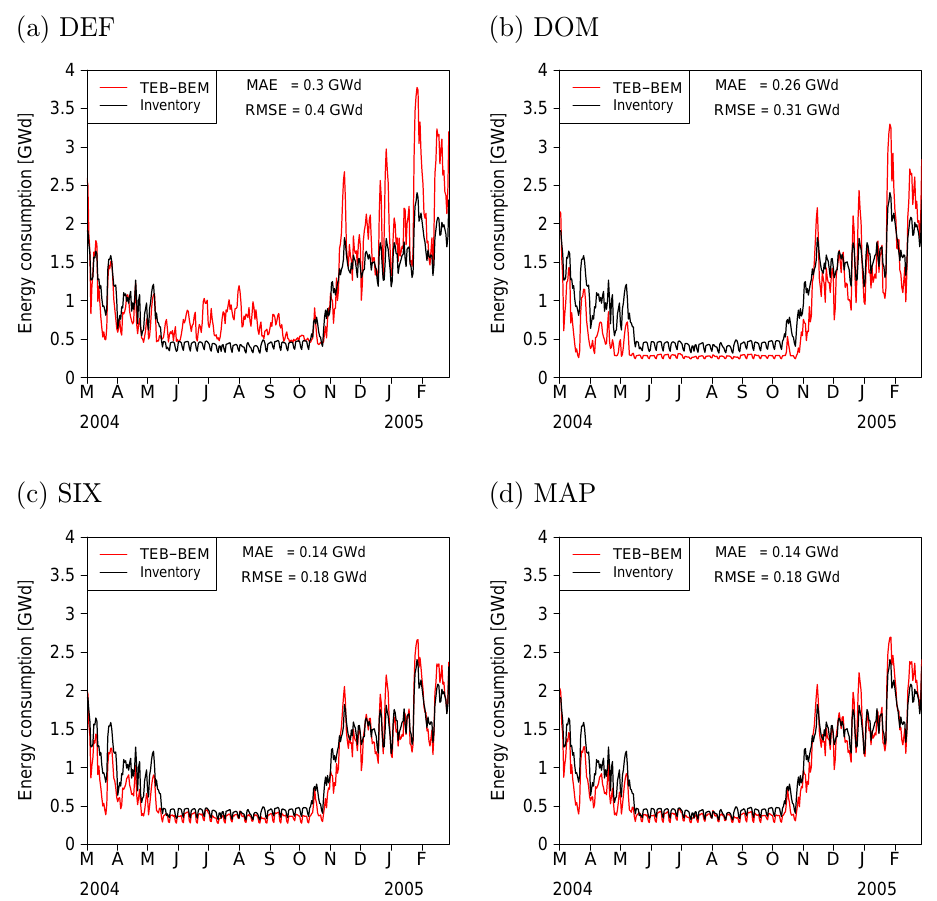
Figure 6. Simulated and observed time series of daily values of building energy consumption aggregated over the agglomeration of Toulouse for (a) uniform default behaviours (DEF), (b) behaviours assigned as a function of the dominant building use (DOM), (c) six uses and behaviours as described in Sect. 3.5, but with neutral behavioural indicators (SIX) and (d) six uses and behaviours and maps of behavioural indicators